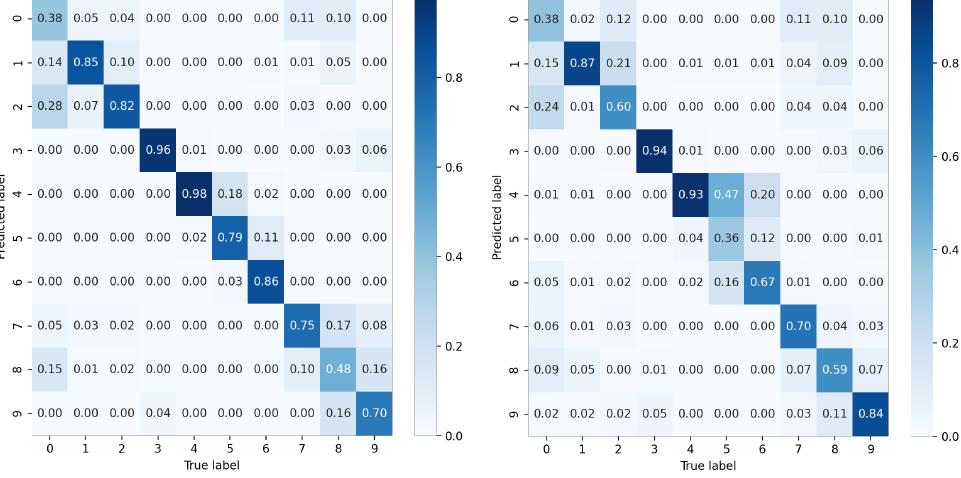
Figure 11. Confusion matrix of the sparse auto-encoder for 10 classes. The left is the confusion matrix of original data. The right is the confusion matrix of the data generated by common